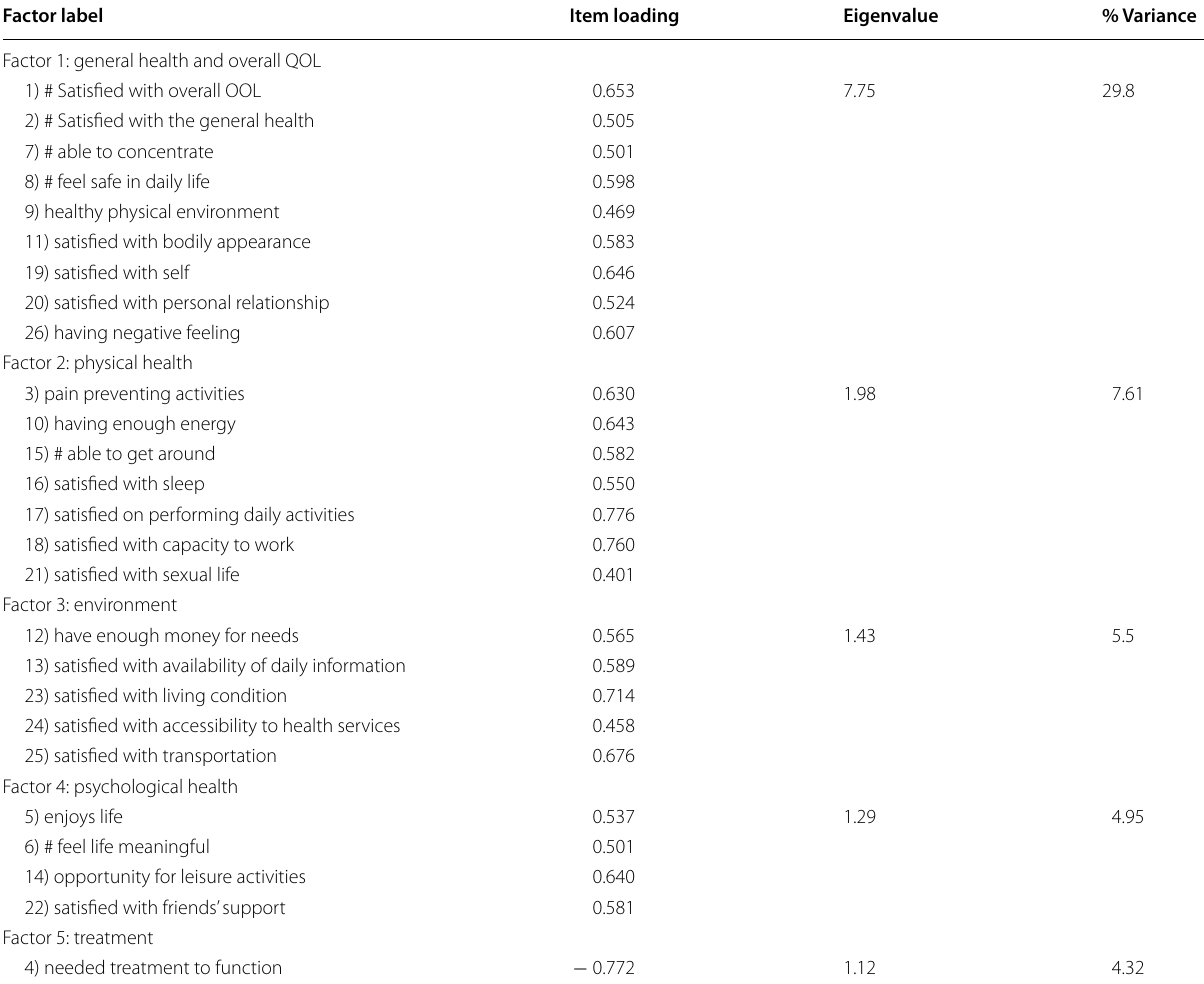
Table 1 Item loading for the factor analysis of the 26 items of the WHOQOL-BREF Factor label Item